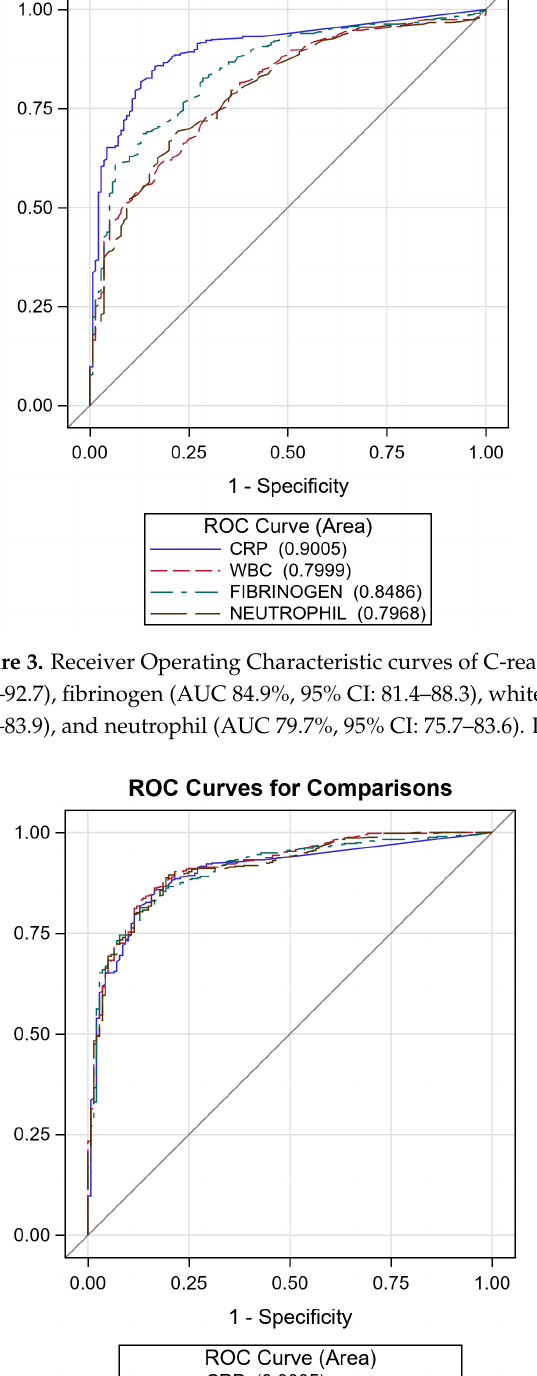
Figure 4. Receiver Operating Characteristic curves of C-reactive protein (CRP) + white blood cells (WBC) (AUC 91.5%, 95% CI: 89.0–93.9), CRP + fibrinogen (AUC 90.6%, 95% CI: 88.0–93.3) and CRP + neutrophil (AUC 90.9%, 95% CI: 88.4–93.5). Diagonal line represents line of reference.